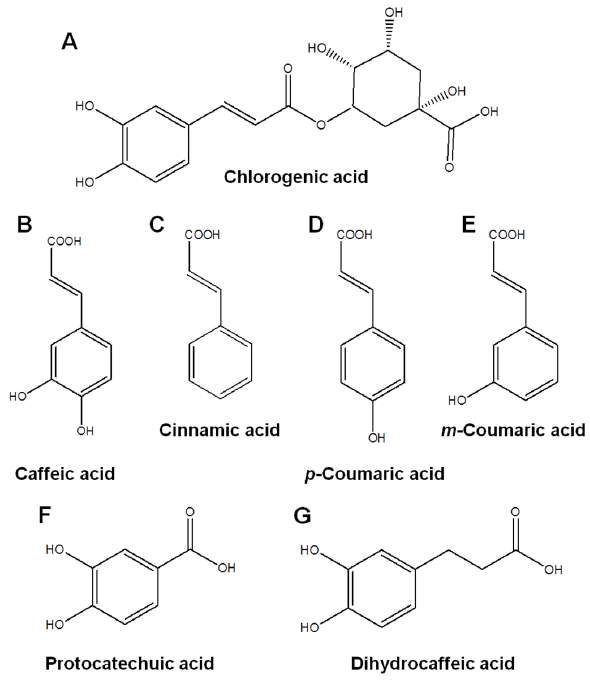
Figure 1. Chemical structures of analogues derived from chlorogenic acid (CHA) and caffeic acid (CA). Chemical structure of CHA ( A ); CA ( B ); cinnamic acid ( C ); p -coumaric acid ( D ); m -coumaric acid ( E ); protocatechuic acid ( F ); and dihydrocaffeic acid ( G ).